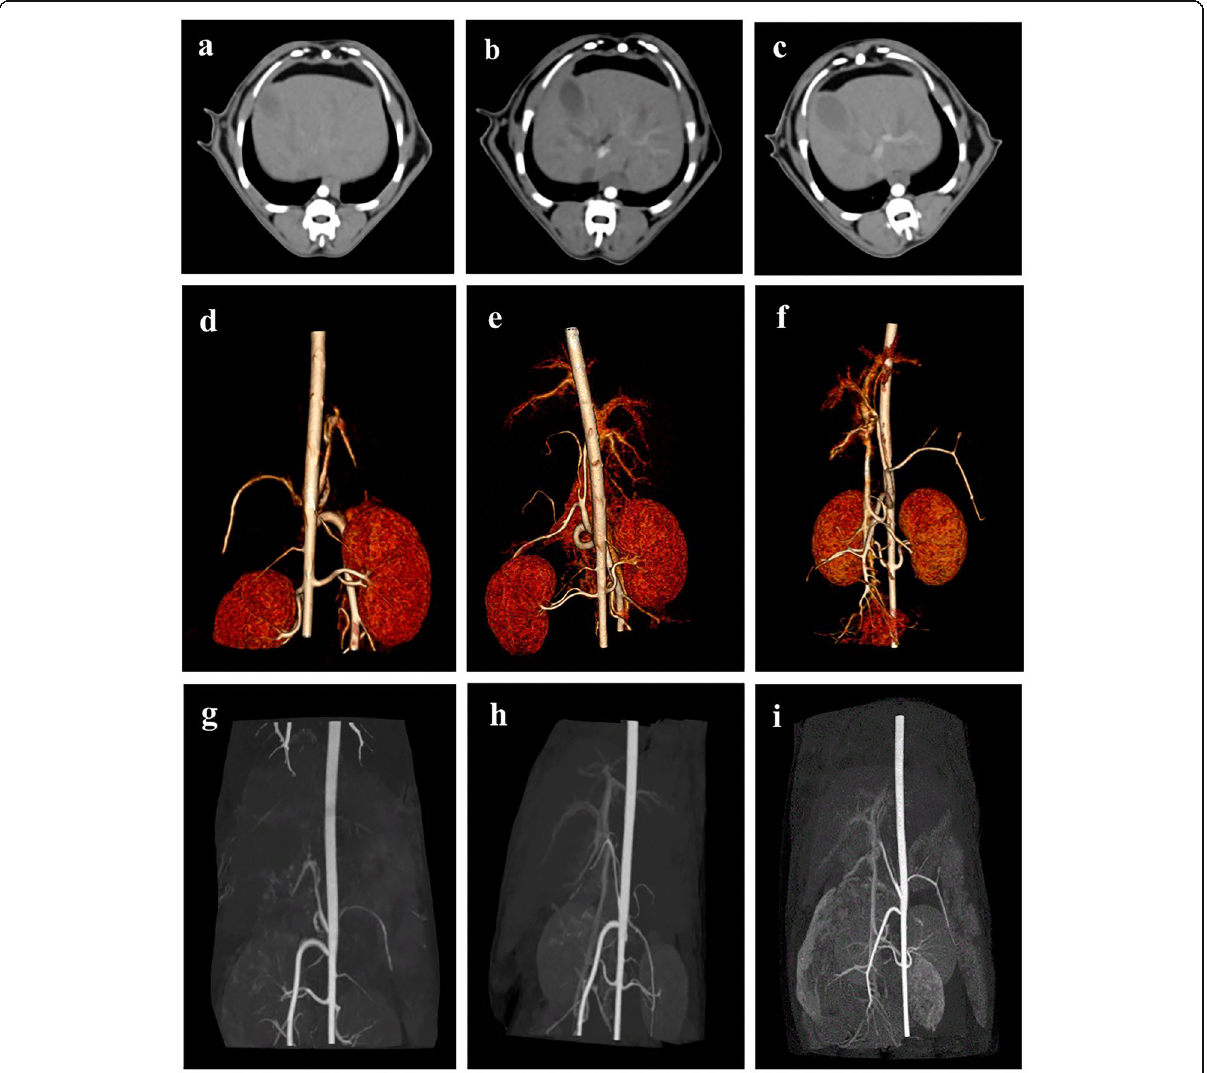
Fig. 2 Triple-phase hepatic CT images of the arterial phase at different TDs (0 s, 2 s and 4 s). The arterial phase images at 0 s TD: hepatic transverse CT image ( a ), hepatic vessels VR image ( d ) and MIP image ( g ). The arterial phase images at 2 s TD: hepatic transverse CT image ( b ), hepatic vessel VR image ( e ) and MIP image ( h ). The arterial phase images at 4 s TD: hepatic transverse CT image ( c ), hepatic vessel VR image ( f ) and MIP image ( i ). All images have the same orientation; R is on the left of the